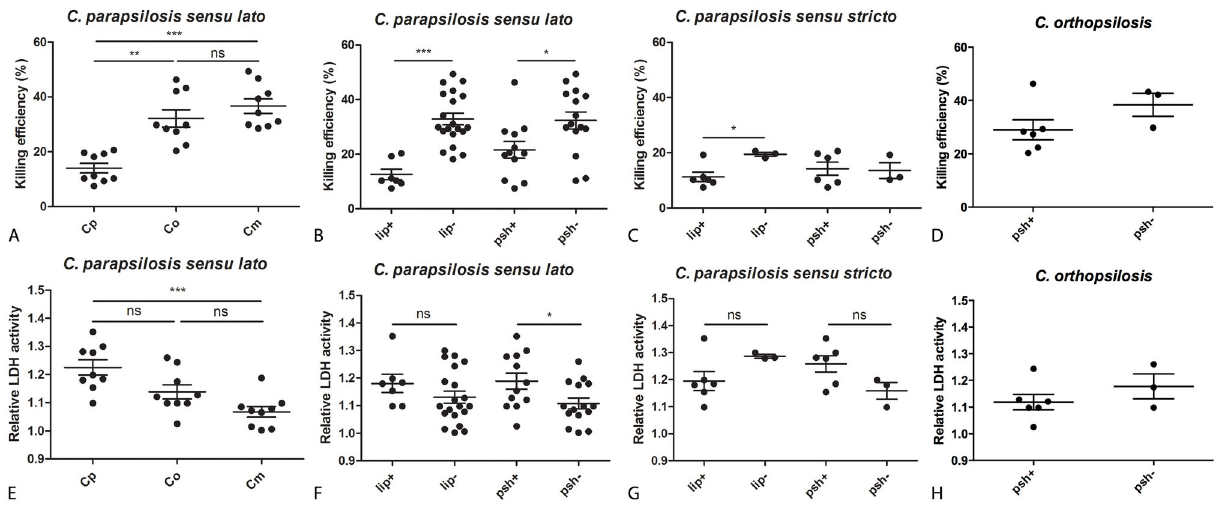
Figure 4. Interactions of different C. parapsilosis sensu lato isolates (see Table S1.) with primary human monocyte- derived